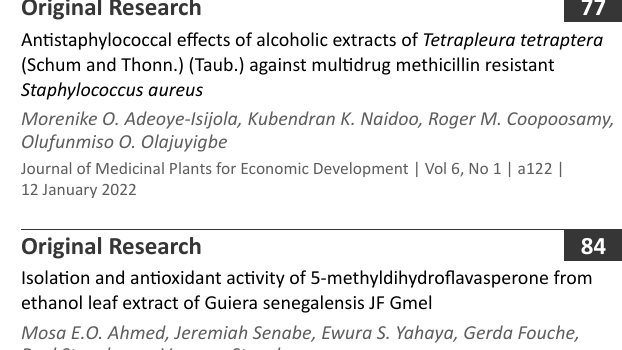
Original Research Antistaphylococcal effects of alcoholic extracts of Tetrapleura